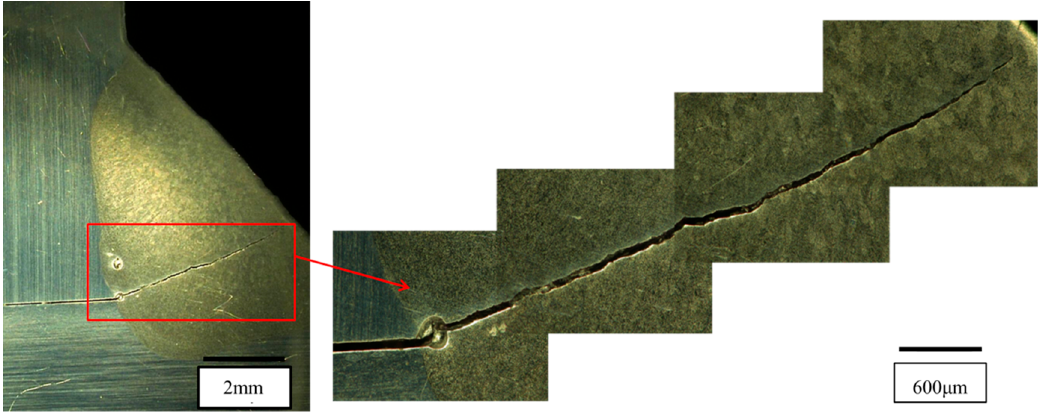
Figure 8. Fatigue crack in T joint of 6082 aluminum alloy.